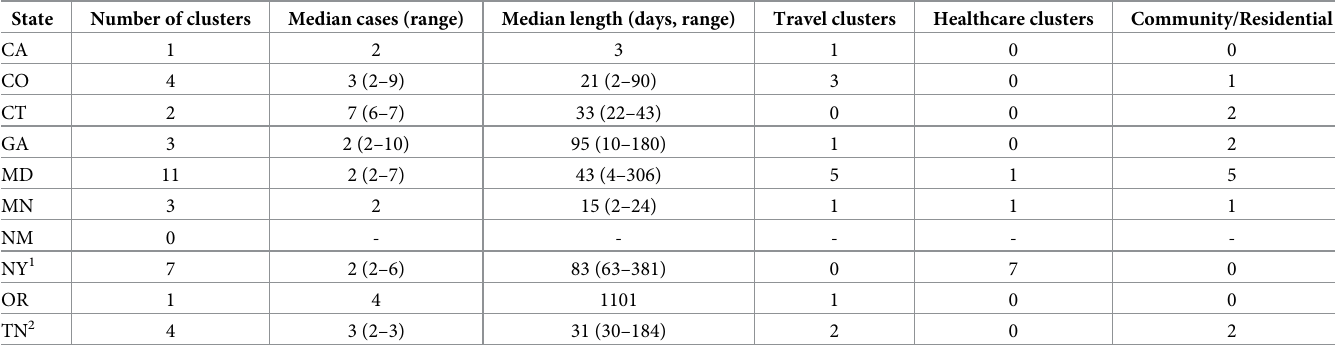
Table 2. Descriptive information from traditionally identified clusters by reporting